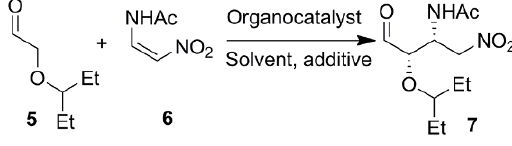
Scheme 2. The reaction of aldehyde 5 with alkene 6